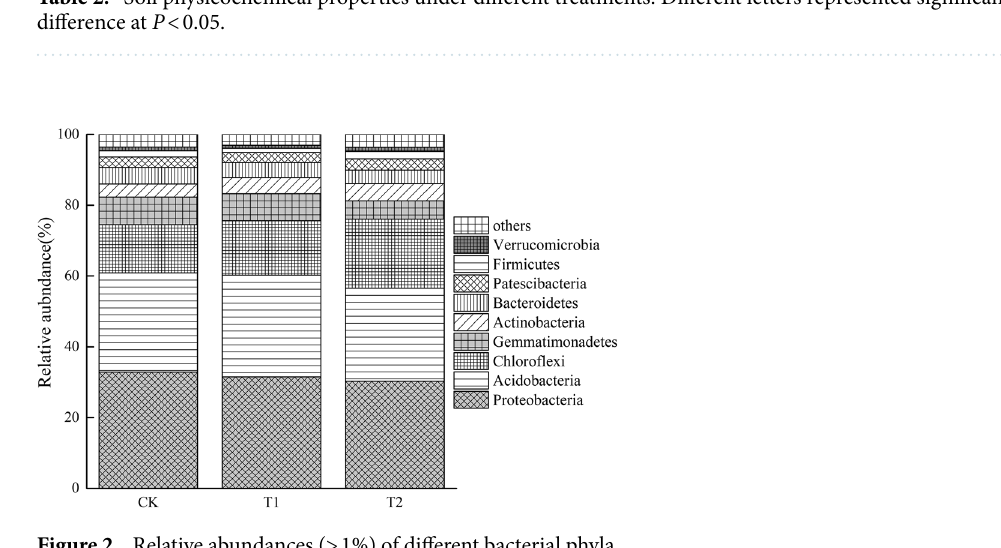
Figure 2. Relative abundances (> 1%) of different bacterial